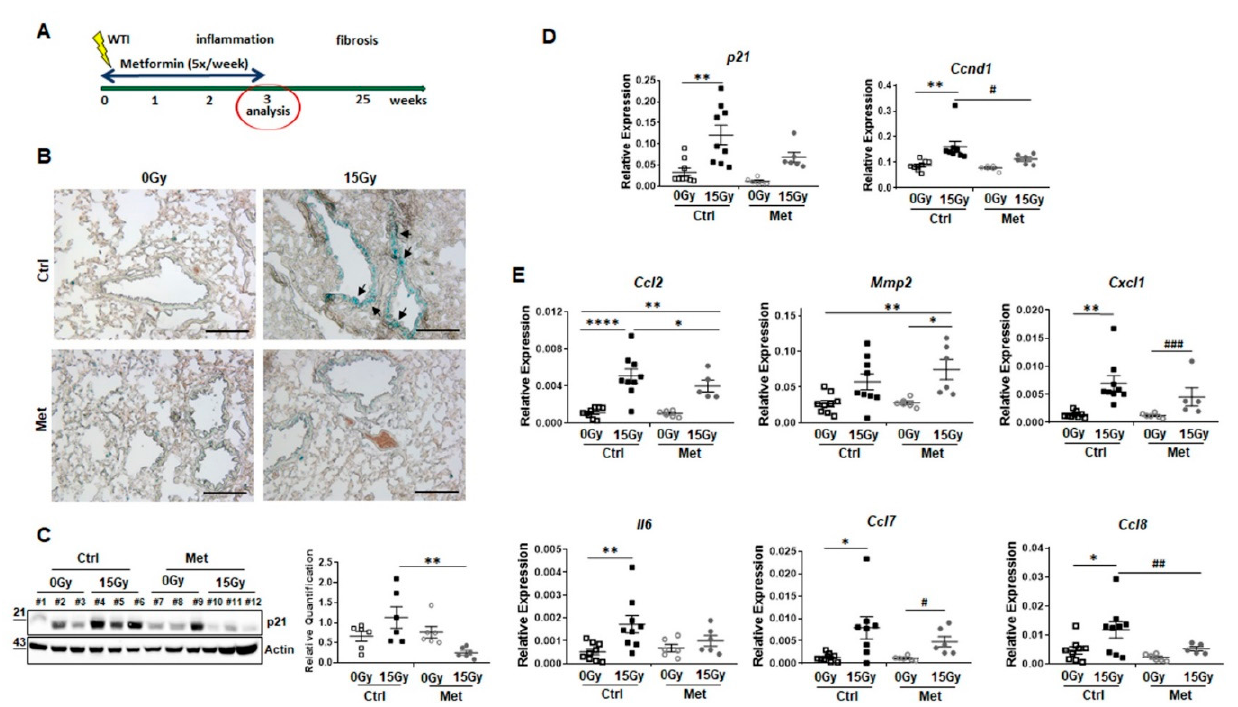
Figure 1. Metformin treatment limits senescence of bronchial–alveolar epithelial cells and associated senescence associated secretory phenotype in whole thorax irradiated mice. ( A ) C57BL/6 mice were left untreated (Ctrl), received five-times a week metformin (Met) treatment, 15Gy whole thorax irradiation (WTI) or received WTI in combination five-times a week metformin treatment for first three weeks post WTI. ( B ) Senescence-associated beta-galactosidase activity was analyzed on frozen lung sections, 21 days post irradiation. Photomicrographs depict representative pictures (scale bar = 200 µm). ( C ) Senescence mediator cyclin-dependent kinase inhibitor 1 (Cdkn1a/p21) protein expressions were analyzed in whole lung protein lysates using Western Blot analyses Expression levels were quantified by densitometry and data are presented as mean values ± SEM of individual biological replicates ( n = 6–9 per group). p -values indicate: ** p ≤ 0.01 by one-way ANOVA with post hoc Tukey’s multiple comparison test. ( D ) Cdkn1a/p21 as well as cyclin D1 ( Ccnd1 ) mRNA expression levels were further quantified using Real-Time RT-PCR. Relative transcript levels were normalized to beta-actin (set as 1). Symbols depict individual biological replicates measured in duplicates each (0Gy and 15Gy Ctrl: n = 9 per group; 0Gy Met, 15Gy Met: n = 6 per group). Data represent mean values ± SEM, p -values indicate: * p ≤ 0.05, ** p ≤ 0.01 by one-way ANOVA with post hoc Tukey’s multiple comparison test. Additional unpaired (two-tailed) t -test analysis is depicted by # p ≤ 0.05. ( E ) SASP factor ( Ccl2 , Mmp2 , Cxcl1, Il6 , Ccl7 , Ccl8 ) expression levels were analyzed (in duplicates) on mRNA level of whole lung RNA isolates (0Gy and 15Gy Ctrl: n = 9 per group; 0Gy Met, 15Gy Met: n = 6 per group). Individual biological replicates and mean values ± SEM are shown. p -values indicate: * p ≤ 0.05, ** p ≤ 0.01, **** p ≤ 0.0001 by one-way ANOVA with post hoc Tukey’s multiple comparison test and additionally by unpaired (two-tailed) t -tests as depicted by ## p ≤ 0.01, ### p ≤ 0.001.